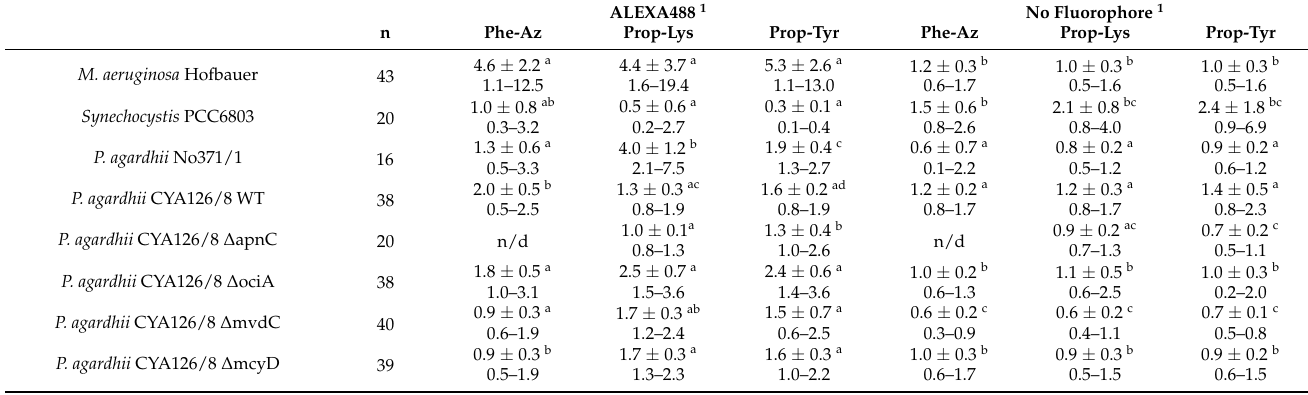
1 For each strain, treatments were compared using Kruskal–Wallis ANOVA on Ranks. We found statistically significant differences between the treatments ( p < 0.001) in all of them. Superscripts indicate homogeneous subgroups not significantly different at p < 0.05 using post-hoc pairwise comparison (Tukey’s test); n/d: no